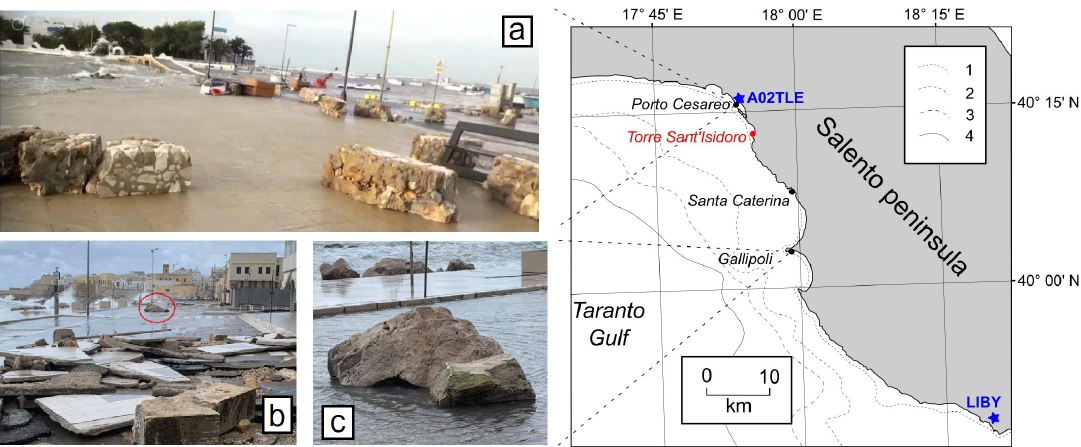
Figure 4. Examples of damages caused by the 12–13 November 2019 storm to some urban areas; ( a ) Porto Cesareo, blocks of a destroyed promenade wall; ( b ) Gallipoli, blocks of promenade wall and pavement, the red circle marks the largest breakwater block displaced during the storm; ( c ) close view of the